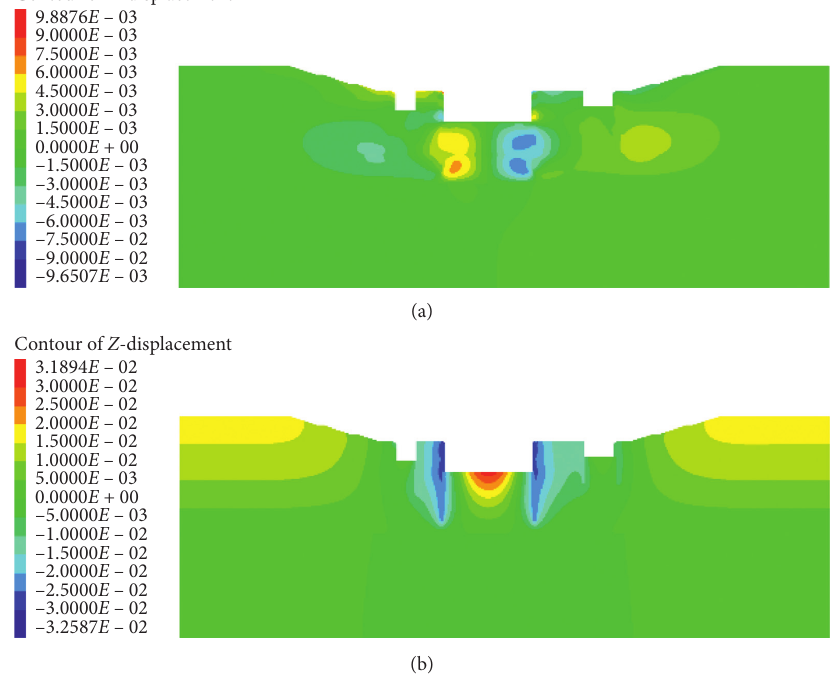
Figure 9: Contour of displacement in the SE area. (a) Contour of X -displacement. (b) Contour of Z